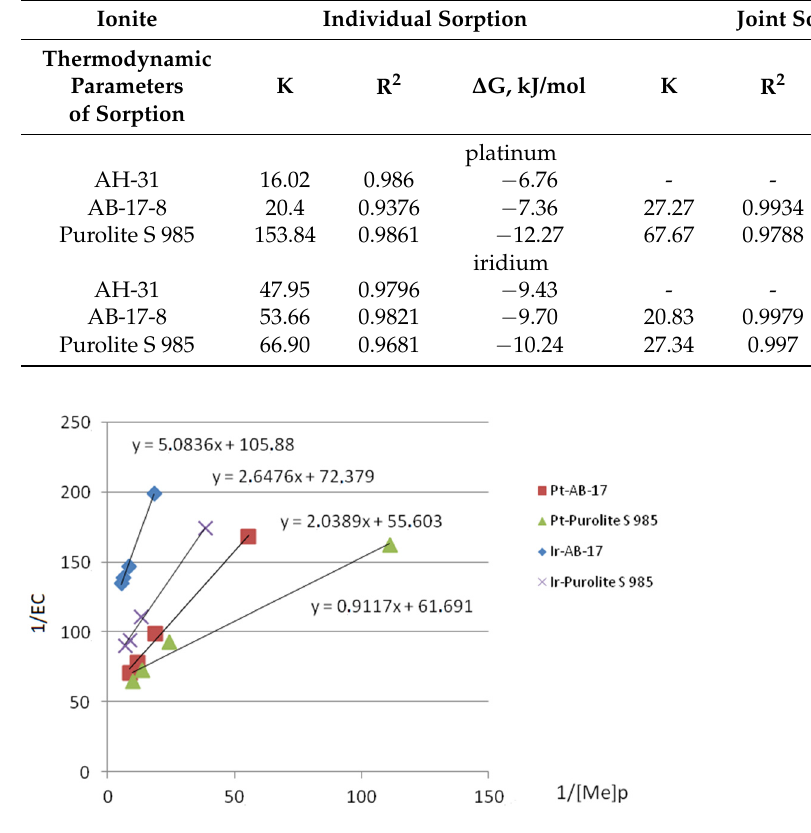
Figure 3. Linearized isotherms of platinum and iridium joint sorption from sulfate-chloride solution: С Me =0.26 mmol/L; С H2SO4 =0.5 mol/L; С HCl =0.5 mol/L.